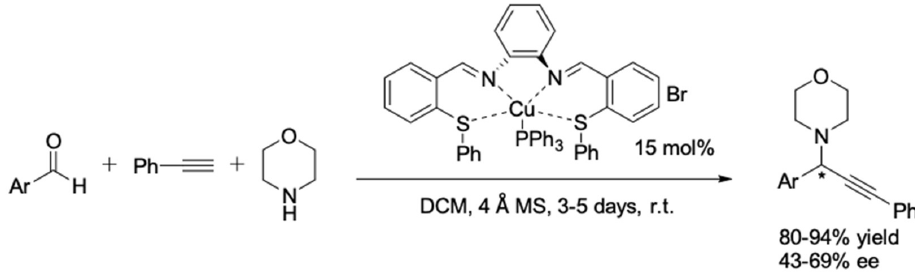
Figure 23. AA 3 -coupling reactions based on Cu(I)/Schiff base complex.